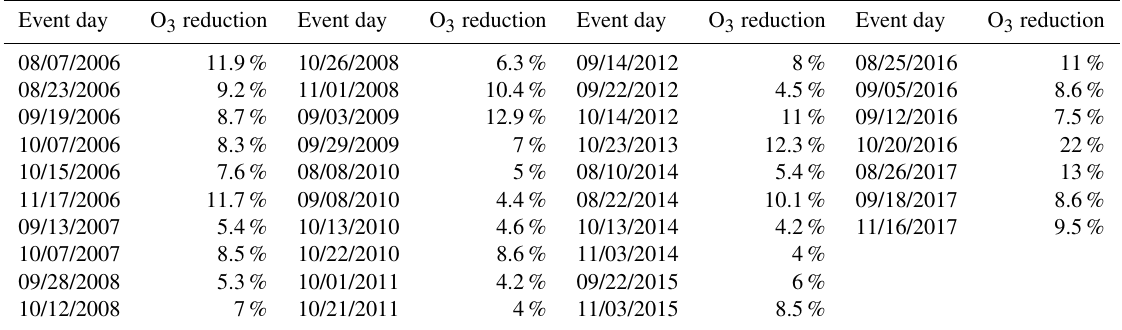
Table 2. Events of the secondary effect of the Antarctic ozone hole over southern Brazil from 2006 to 2017. Average daily TOC value and percentage of O 3 reduction with respect to the climatological average of the